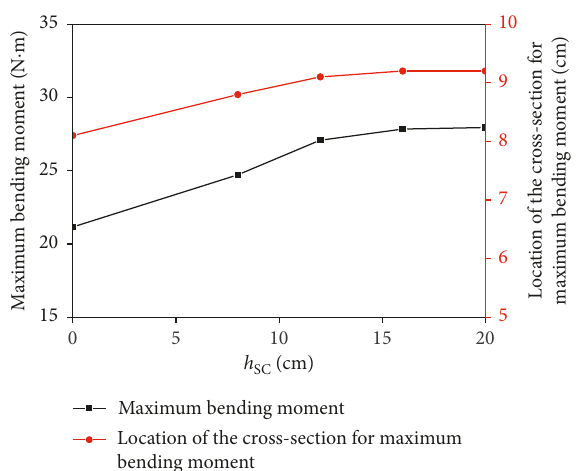
Figure 19: Change rule of the maximum bending moment of the CCFSTP and the location of the cross-section of the CCFSTP at which the maximum bending moment